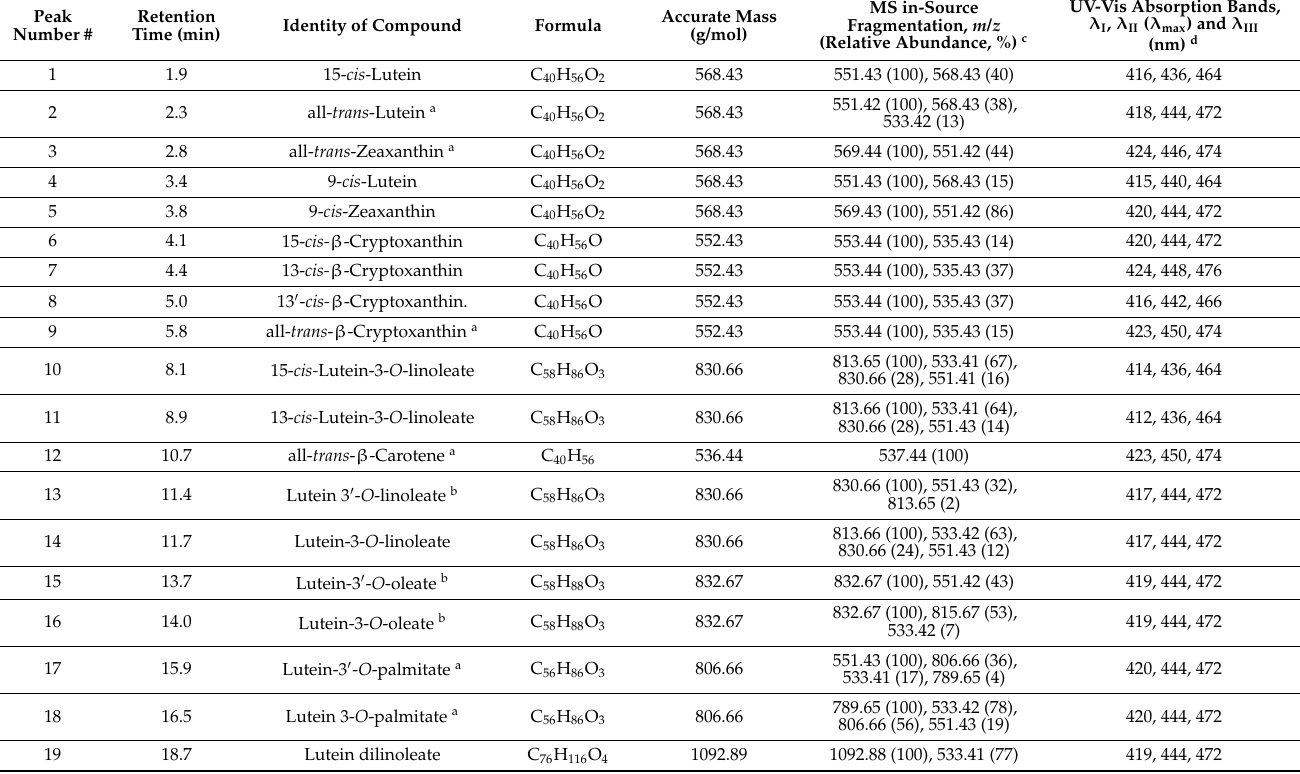
Table 1. Detailed composition of carotenoids identified in hairless canary seed and their chromato- graphic and spectrometric